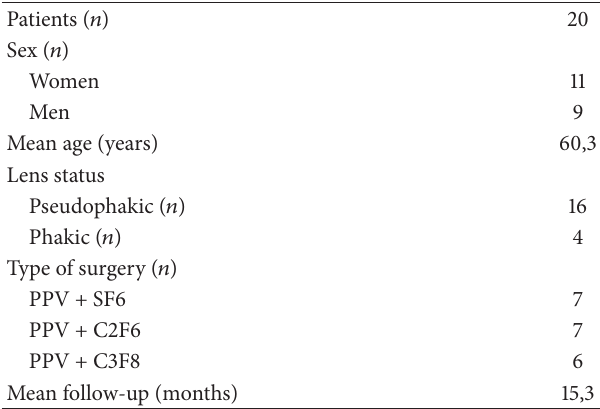
Table 1: Patients’ demographic